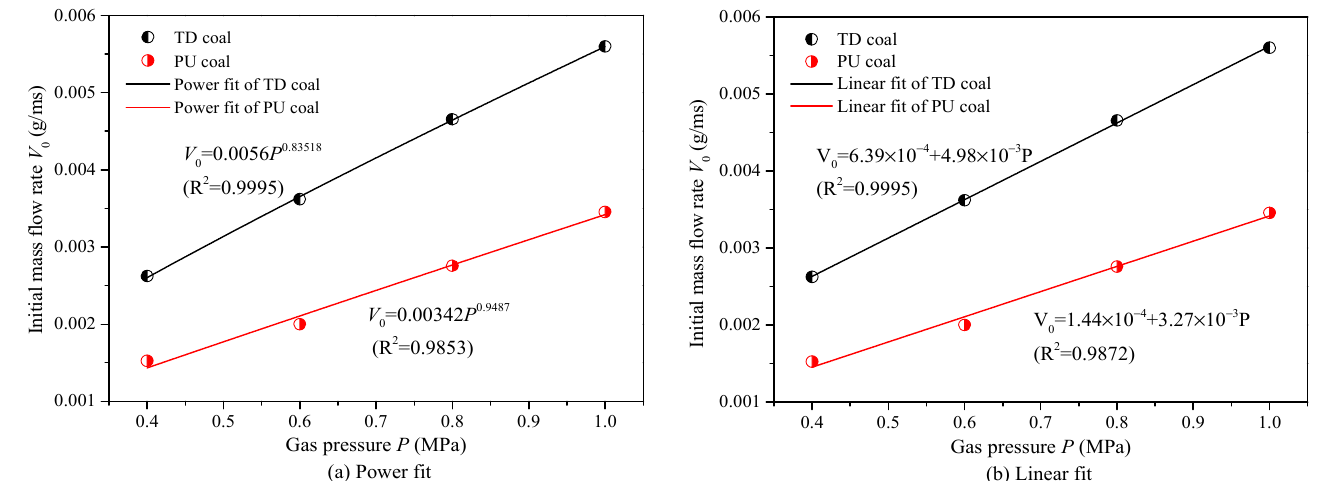
Figure 7. Correlation of the mass flow rate vs. gas pressure at the initial time.